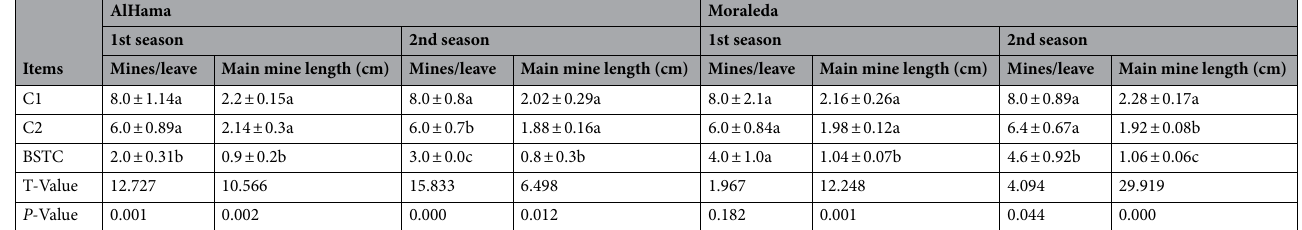
Table 3. Average numbers of mines and tunnel length per leave produced by larvae of L. trifolii in common bean sprayed with BSTC, YE and water during cultivating seasons 2019 & 2020. C1 water sprayed plants as negative control. C2 sprayed plants with yeast extract as positive control.